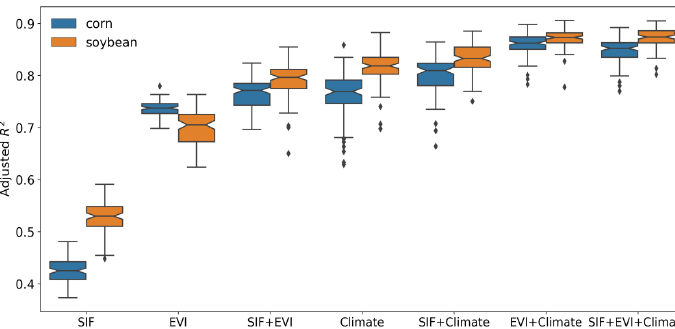
Figure 4. The box plot of adjusted R 2 of 100 experiments for different DNNs. The boxes show the interquartile range (IQR), from 25 th percentile to 75 th percentile, of the R 2 distribution, while the whiskers extend the low and high quartiles by 1.5 times IQR values. The black points outside the boxplots are the outlier experiments that were outside the range of plot whiskers.